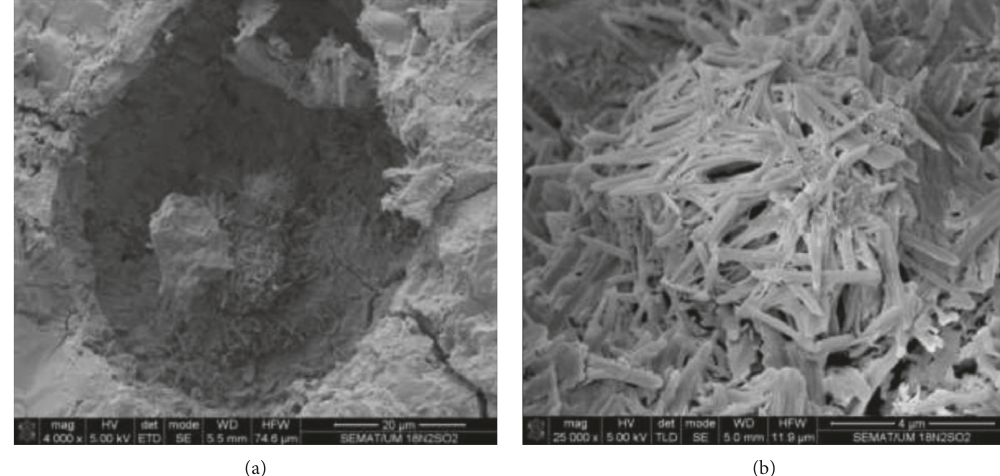
Figure 13: (a) A shot of concrete treated with coat after 18months in gaseous SO gypsum